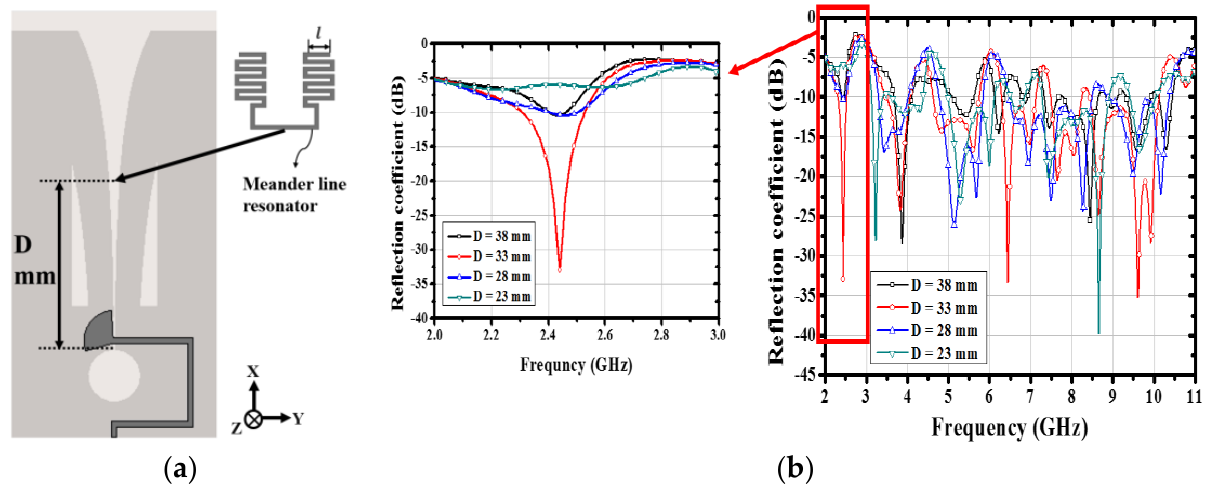
Figure 7. ( a ) The integrated position of the meander line resonator for narrowband operation and ( b ) comparison of the simulated reflection coefficients in terms of position D.